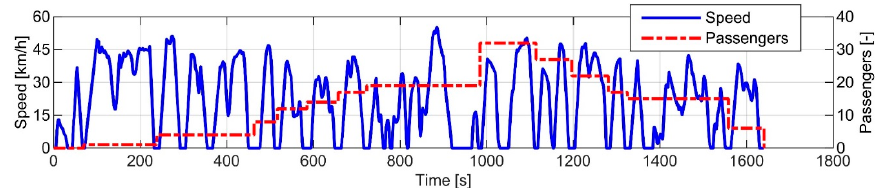
Figure 5. Example of a synthetic Espoo 11 driving cycle and number of passengers. Table 3. Parameter distribution statistics of the synthetic driving cycles.